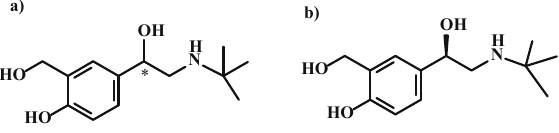
Figure 5: Chemical structures of ( a ) ( RS )-(±)- albuterol ( salbutamol ) and ( b ) ( R )-( − )- albuterol ( salbutamol )